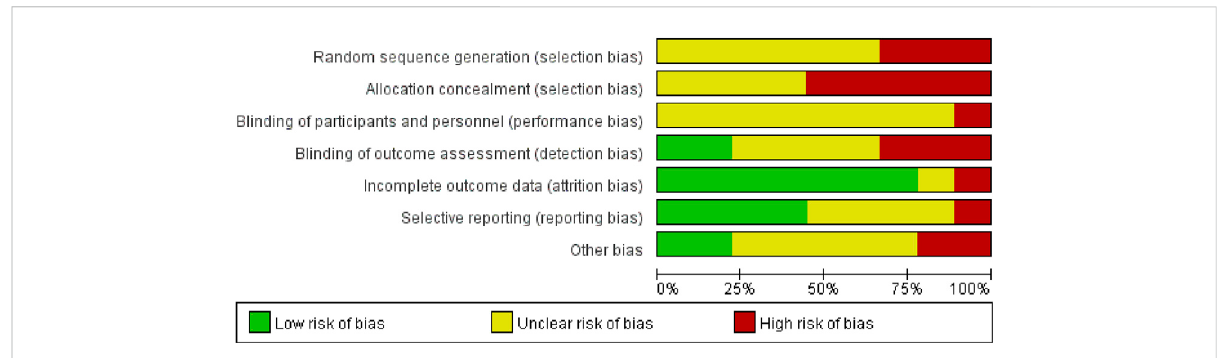
FIGURE 3 Risk of bias graph: review of the authors ’ judgements regrading each risk of bias item presented as percentages across all included